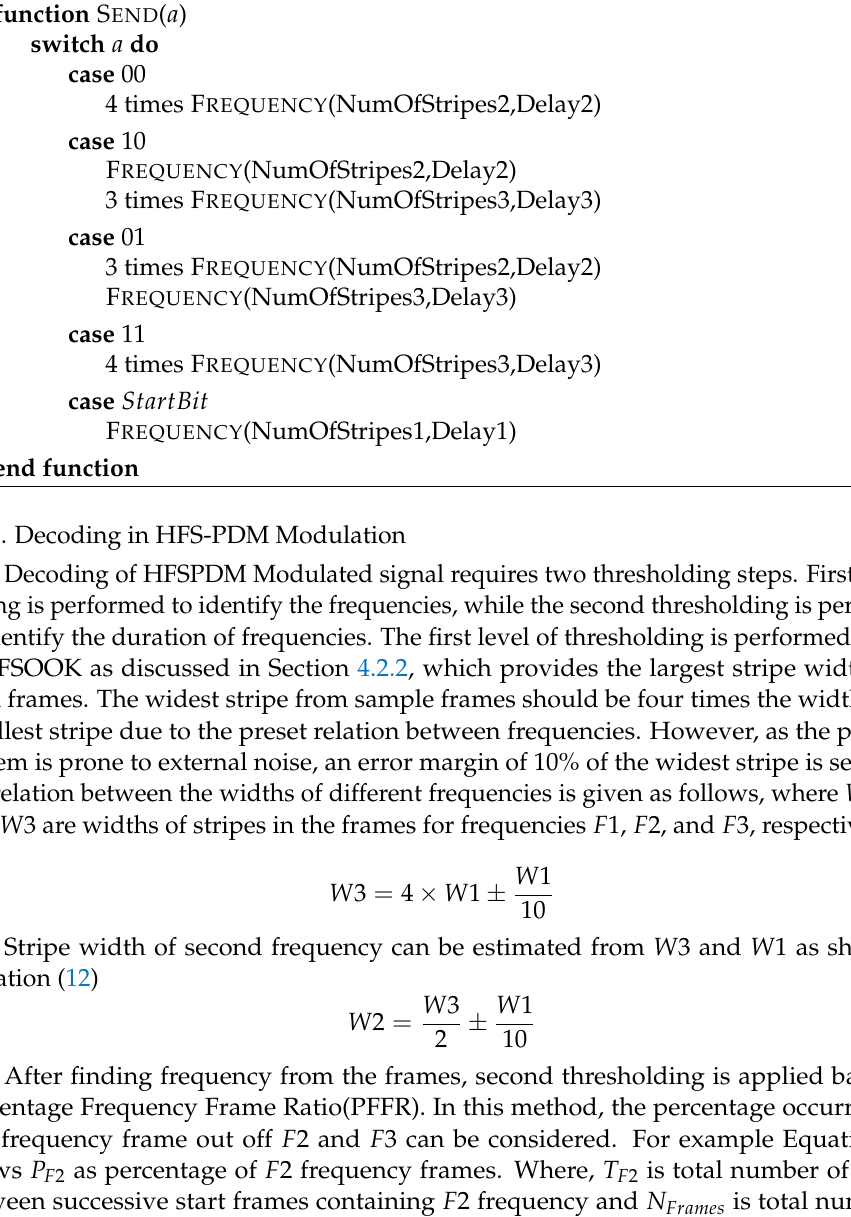
Algorithm 6 HFSPDM for Li-Fi